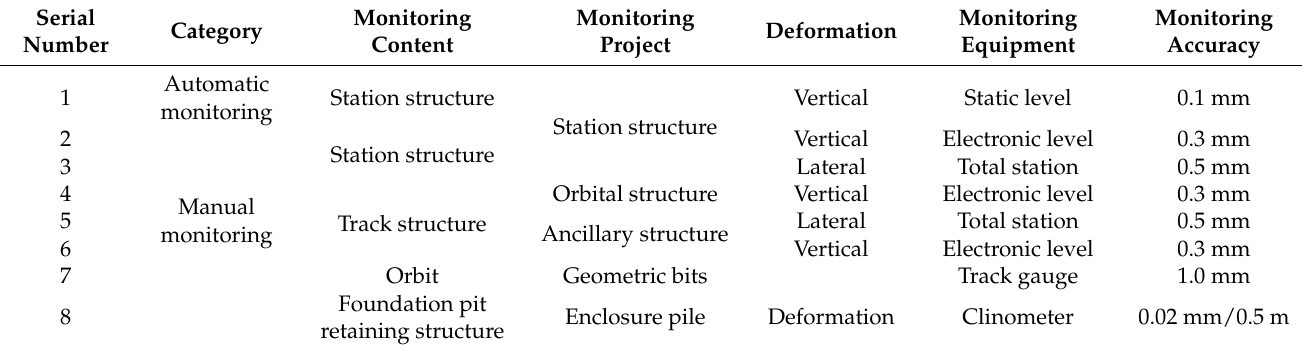
Table 2. The main content of foundation pit engineering